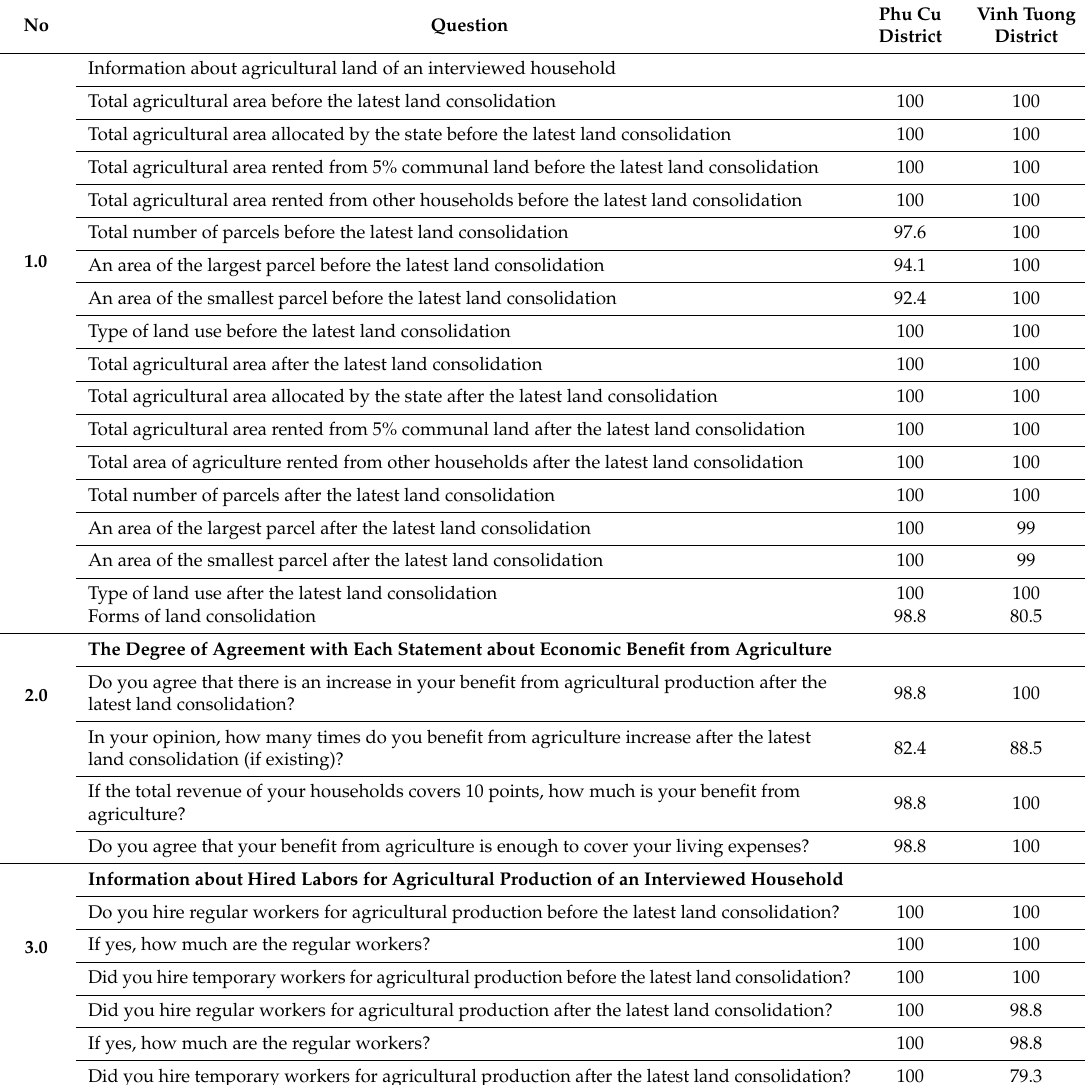
Table 3. Percentage of responses for each question in structured